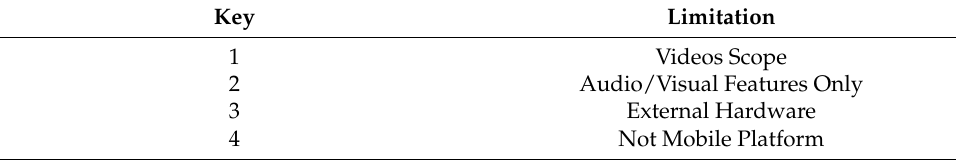
Table 1. Keys of limitations for Table 2.